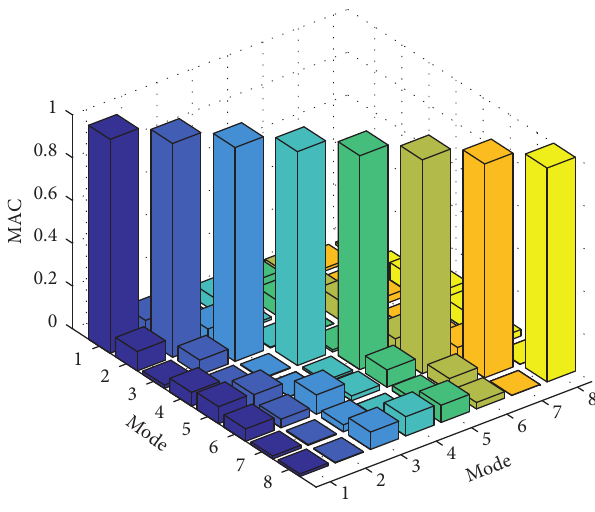
Figure 9: 11-sensor iteration curve.